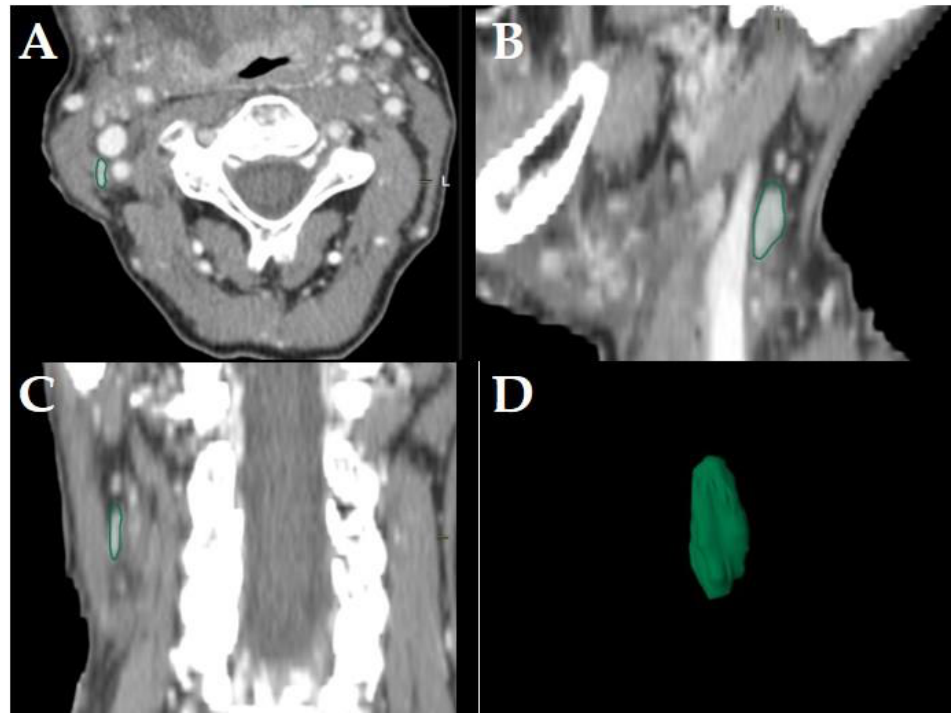
Figure 4. Example of a LN classified as “non-pathologic” in a staging-CT of a 65-year-old, female HNSCC-patient with a tumor of the oral cavity staged cT4a cN2c cM0. Manually segmented LN in the axial plane ( A ); sagittal ( B ), coronal ( C ) reformatted views and three-dimensional rendering ( D )